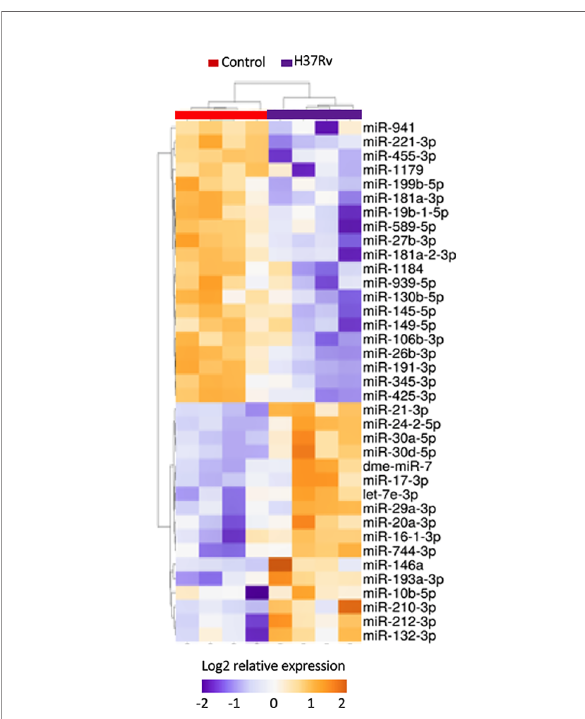
FIGURE 3 | Expression levels of miRNAs signi fi cantly deregulated after H37Rv infection. THP-1 differentiated into macrophages were infected with H37Rv for 48 hours (n = 4). After total RNA including small RNA extraction, the expression level quanti fi cation of 762 human miRNAs was performed using TaqMan ® Array Human MicroRNA Card. Using Clustvis software, a supervised hierarchical analysis of the distribution of macrophage samples based on relative log2 expression of 37 miRNAs signi fi cantly modi fi ed by H37Rv infection compared to uninfected controls. Statistical analysis was performed on D Ct using Student ’ s t test to identify the differently expressed miRNAs compared with uninfected controls. Imputation was used for missing value estimation. Samples were clustered using the correlation distance method and average linkage.